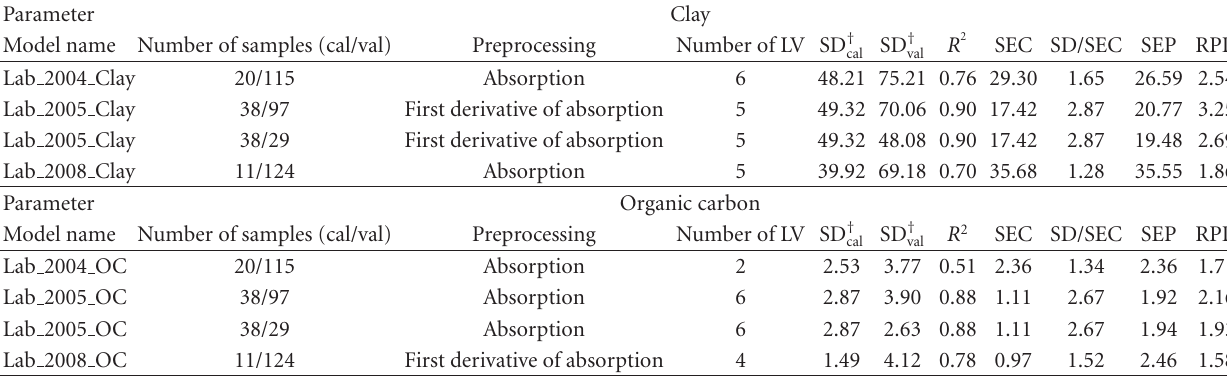
Table 5: Calibration and validation performance statistics of laboratory spectra. Parameter